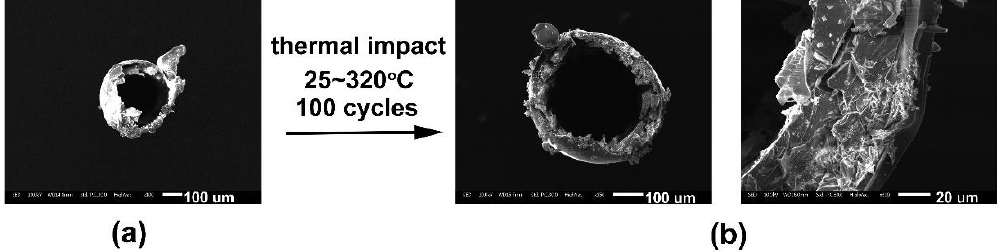
Figure 9. SEM images of PI-5-coated CC samples before and after thermal impact: ( a ) before test and ( b ) after test.